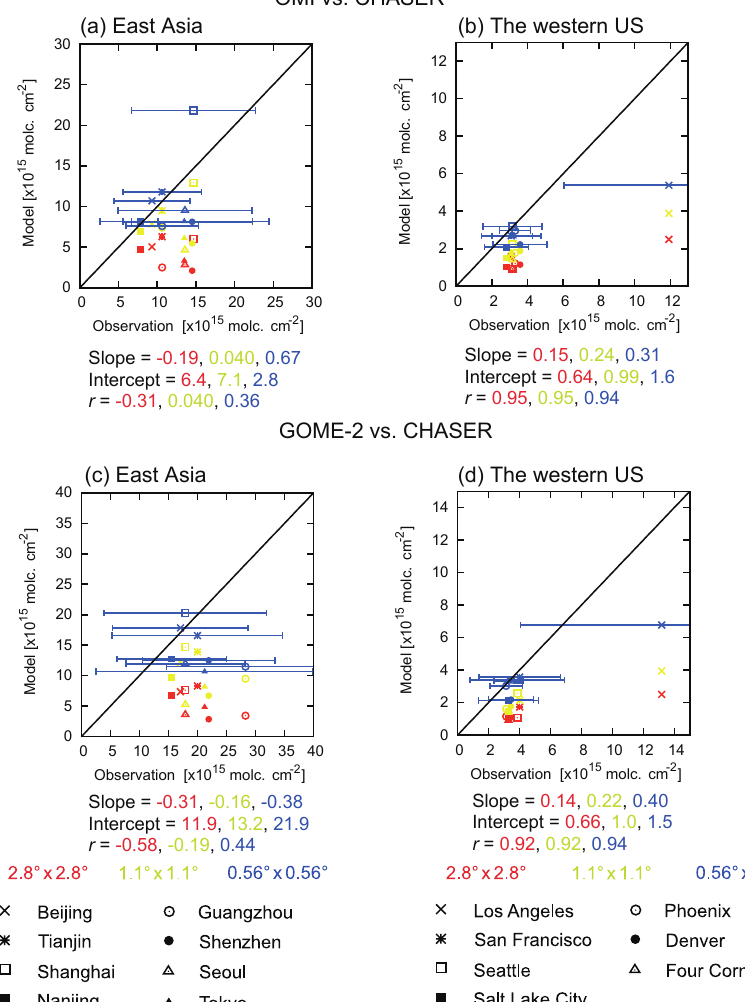
Figure 8. Scatter plots of observed and simulated tropospheric NO 2 column ( × 10 15 moleculescm − 2 ) over strong local sources in East Asia (left column; a , c ) and the western United States (right column; b , d ) during JJA 2008 for the OMI retrievals (upper row; a–b ) and GOME-2 retrievals (lower row; c–d ). The red marks are the model simulation at 2.8 ◦ resolution, the yellow marks are the model simulation at 1.1 ◦ resolution, and the blue marks are the model simulation at 0.56 ◦ resolution. The horizontal bars indicate mean retrieval errors in OMI and GOME-2. For East Asia, the results are shown for Beijing (116.38 ◦ E, 39.92 ◦ N), Tianjin (117.18 ◦ E, 39.13 ◦ N), Shanghai (121.47 ◦ E, 31.23 ◦ N), Nanjing (118.77 ◦ E, 32.05 ◦ N), Guangzhou (113.27 ◦ E, 23.13 ◦ N), Shenzhen (114.10 ◦ E, 22.55 ◦ N), Seoul (126.96 ◦ E, 37.57 ◦ N), and Tokyo (139.68 ◦ E, 35.68 ◦ N). For the western United States, the results are shown for Los Angeles (118.25 ◦ W, 34.05 ◦ N), San Fran- cisco (122.42 ◦ W, 37.78 ◦ N), Seattle (122.33 ◦ W, 47.61 ◦ N), Salt Lake City (111.88 ◦ E, 40.75 ◦ N), Phoenix (112.07 ◦ W, 33.45 ◦ N), Denver (104.88 ◦ W, 39.76 ◦ N), and the Four Corners and San Juan power plants (108.48 ◦ W, 36.69 ◦ N). The values and mean retrieval errors are averages within a 50km distance from each strong source, with weighting function application based on the inverse of the distance from each